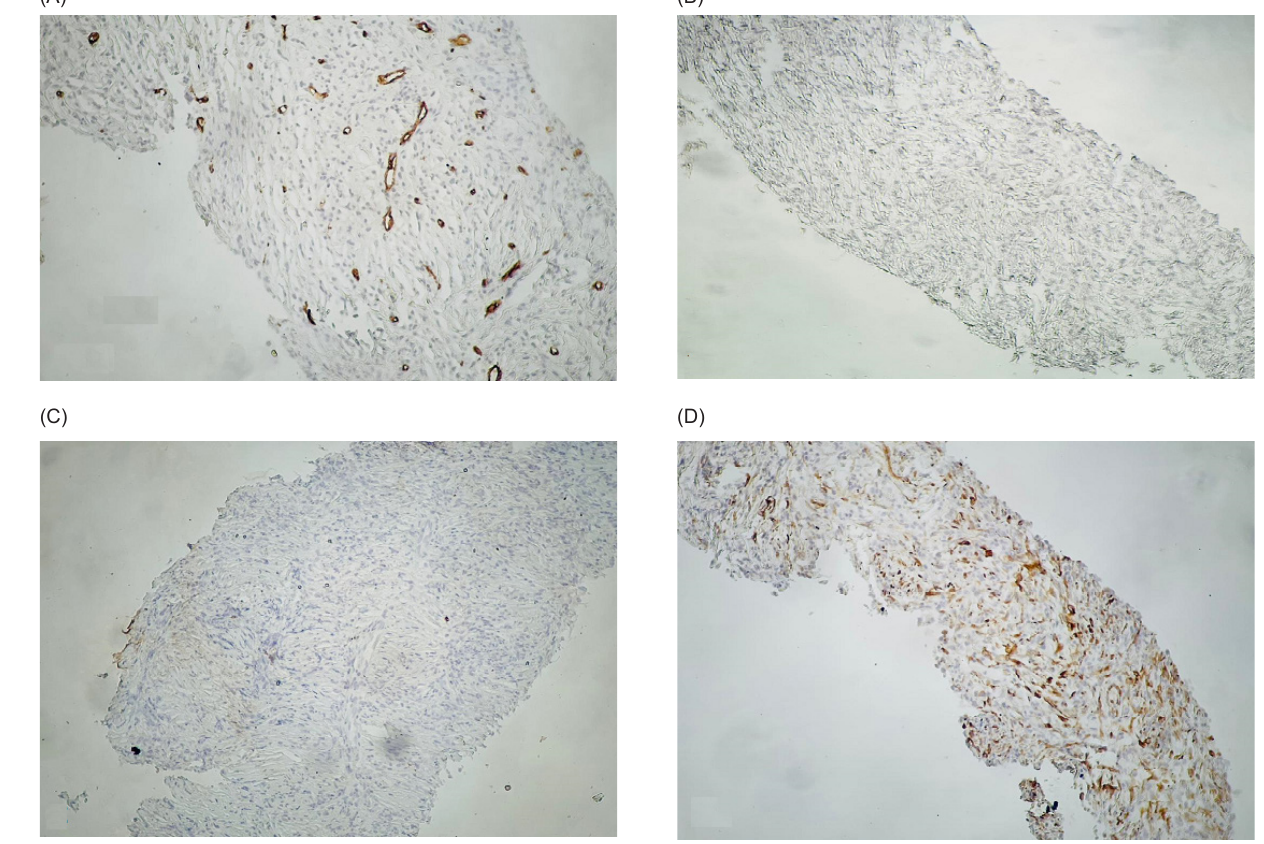
FIGURE 3: Immunohistochemistry (IHC) analyses revealed negative reactions for (A) CD34, (B) Activin receptor-like kinase (ALK), (C) Pan-cytokeratin, and (D)